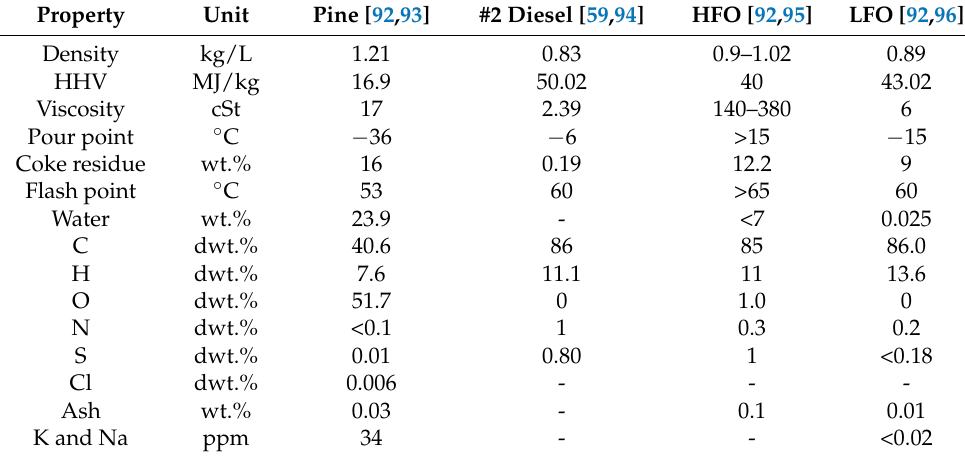
Table 6. Properties of bio-oil and diesel